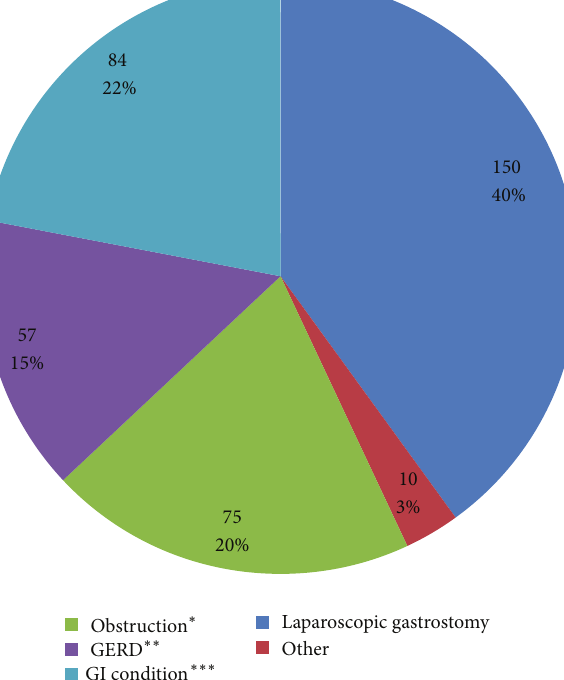
Figure3:Distributionofindicationsforallgastroscopiesperformed on children from 0 to 15 years of age from July 2011 to May 2014. ∗ Obstruction in the upper gastrointestinal tract, ∗∗ gastroesophageal reflux disease, and ∗∗∗ investigation of gastroenterological condi-